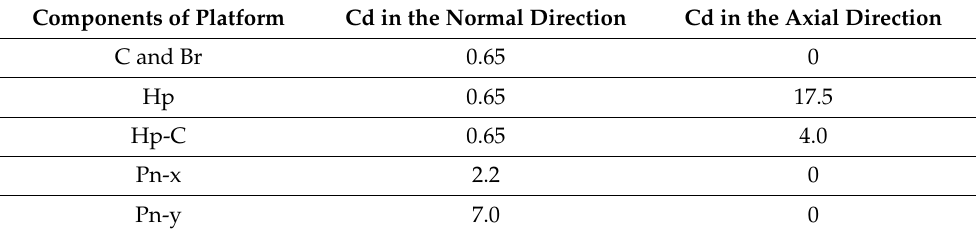
Table 3. Drag coefficients Cd for each component of platform in Figure 1.